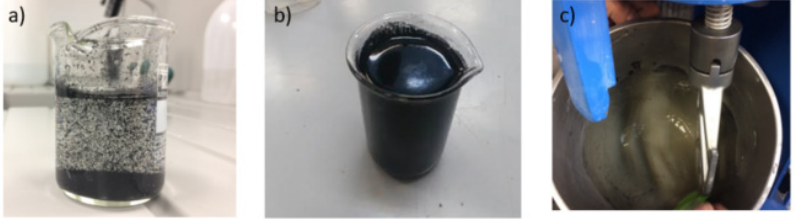
Figure 1. ( a ) Water + carbon nanotubes before ultrasonic dispersion; ( b ) water + carbon nanotubes after ultrasonic dispersion; ( c ) water + carbon nanotubes dispersion + cement paste after mixing.